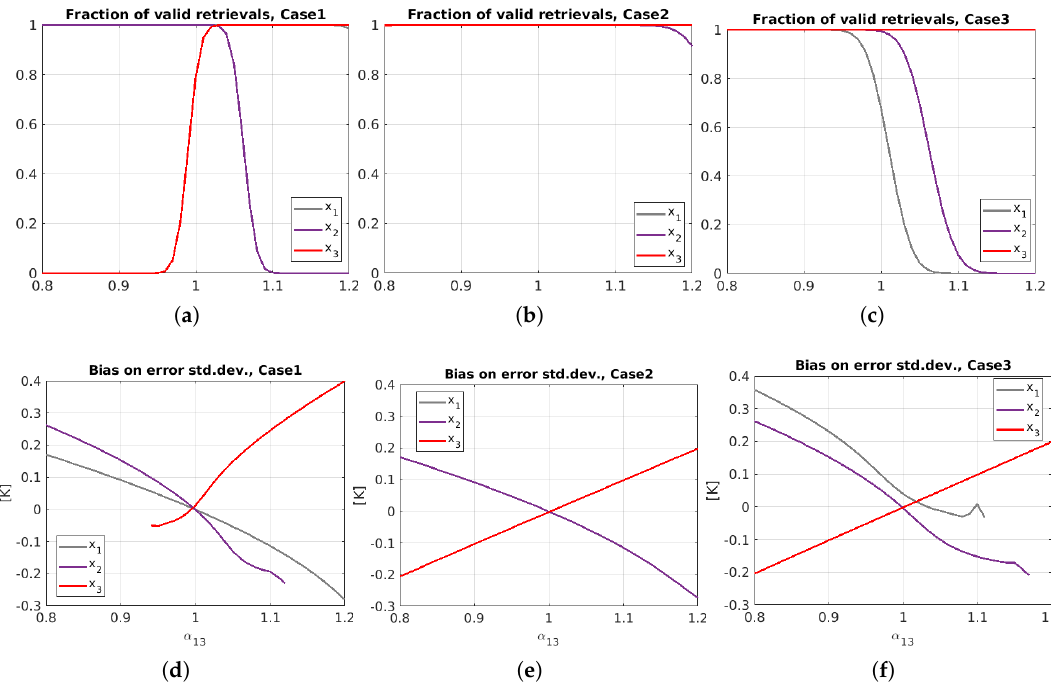
Figure 5. Assessment of the impact of varying the intercalibration factor α 13 on the estimates provided by Correlated Triple Collocation (CTC). Top: Number of valid retrievals per measurement as a function of the α 13 value (measurements 1, 2, and 3 are attributed to the colors grey, purple, and red, respectively). Bottom: Biases on the retrieved error standard deviations as a function of α 13 . The columns from left to right are for the “small uncorrelated”, “equal”, and "large uncorrelated" cases defined in Section